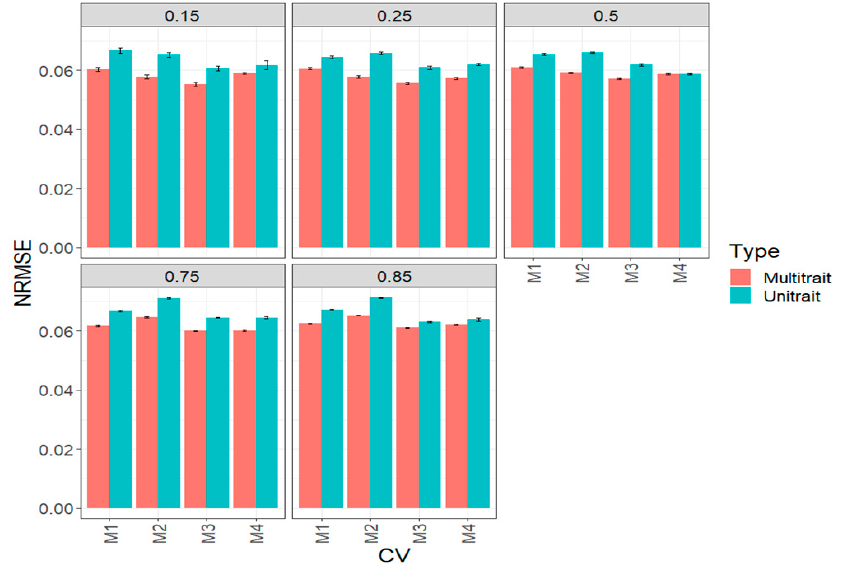
Figure 7. Prediction performance across data sets in terms of normalized root mean square error (NRMSE) of the four methods of sparse testing (M1, M2, M3 and M4) under unit-trait and multi-trait models for 5 percentages of testing: 15% (0.1), 25% (0.25), 50% (0.5), 75% (0.75) and 85% (0.85).